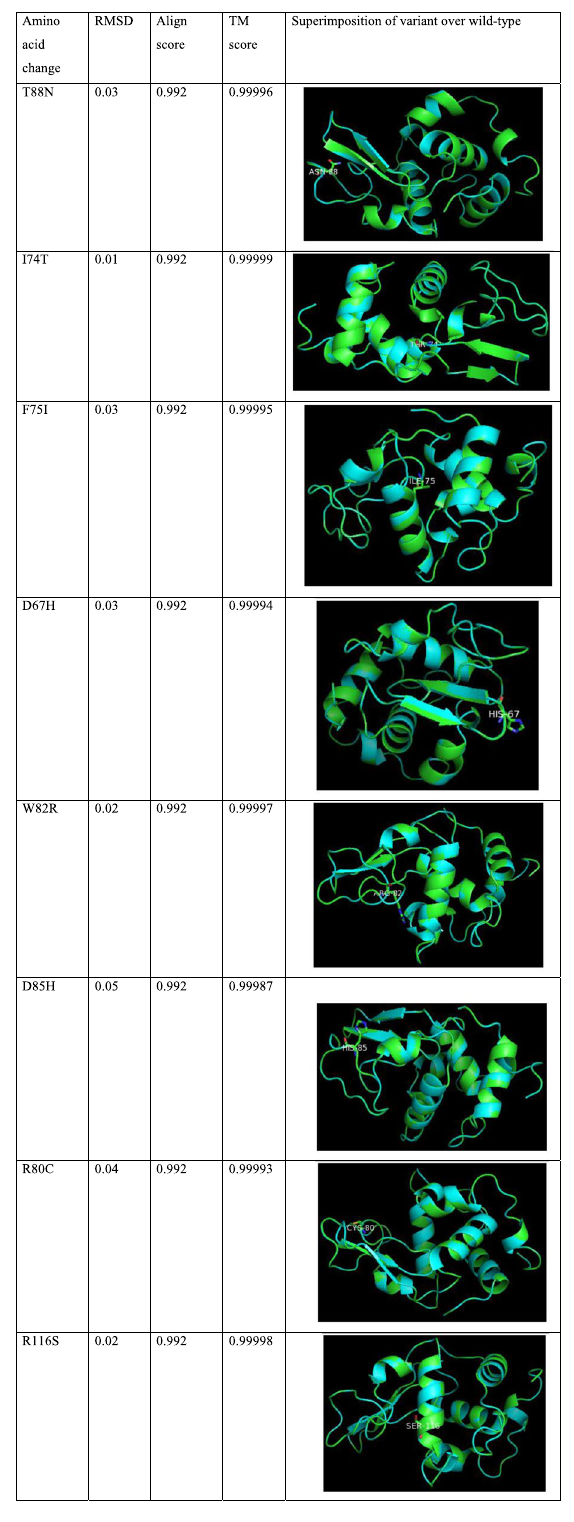
as given by TM-align tool